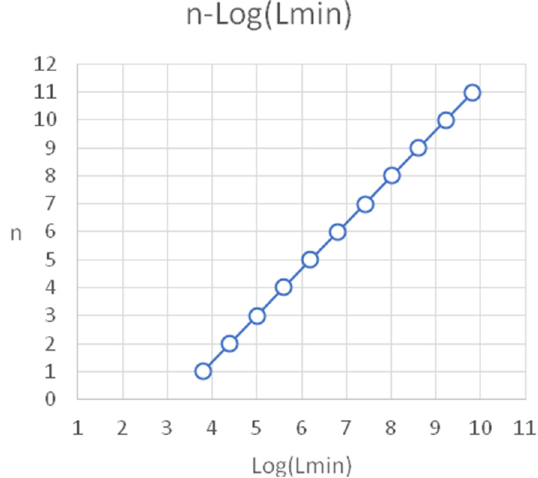
Figure 4. Diagrammatic presentation of the logarithmic relation between oligonucleotides of order n vs. the minimal length L min of a human genome sequence (columns 1 and 4 from Table 2). The graph is a straight line, parallel to the diagonal. Changes in empirical genomic length were used to gauge the results of translating a straight line parallel to itself.